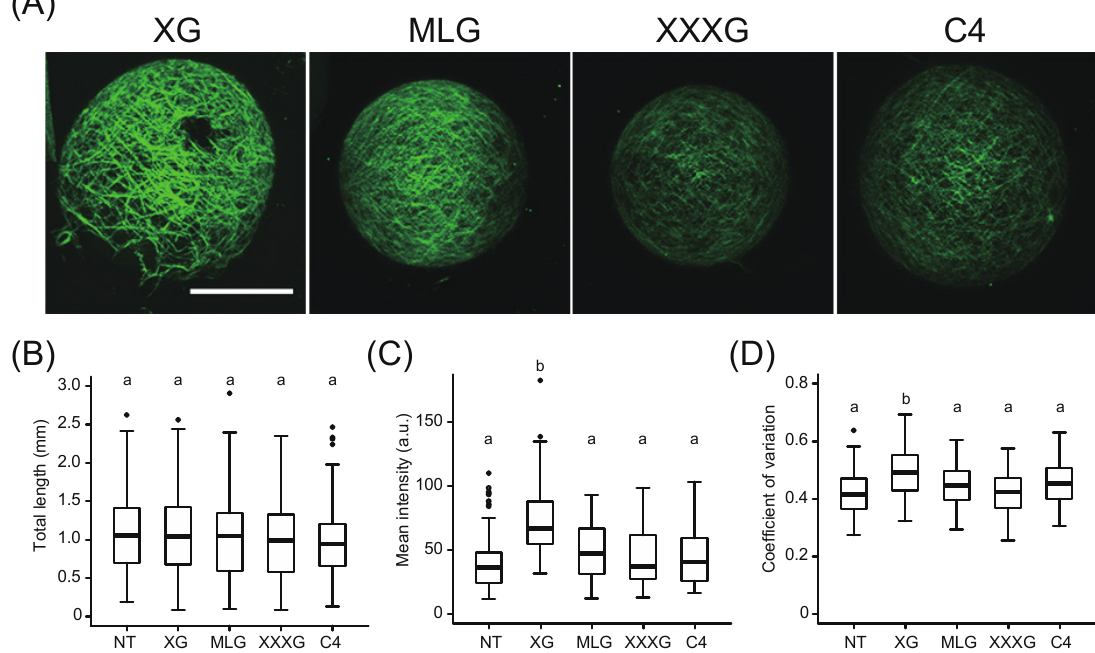
Figure 2. Effect of exogenous application of various polysaccharides or oligosaccharides on cell wall regeneration from xxt1 xxt2 protoplasts. ( A ) Representative images of Calcofluor-stained fiber regenerated from xxt1 xxt2 protoplasts incubated in the regeneration medium containing various polysaccharides or oligosaccharides for 24 h. Scale bar = 20 μ m. ( B – D ) Total length ( B ), mean intensity ( C ), and CV of fluorescence intensity distribution ( D ) of Calcofluor-stained network on the surface of xxt1 xxt2 protoplasts. NT, no treatment; XG, xyloglucan; MLG, mixed-linkage glucan; XXXG, xyloglucan oligosaccharide; C4, cellotetraose. Center lines of box-plot show the medians, boxes indicate interquartile range (IQR), whiskers indicate 1.5 IQR, and outliers are shown by dots. Significance was determined by Tukey–Kramer test. Values with “a” and “b” are statistically different at p < 0.01. n = 108 (NT), 112(XG), 109(MLG), 87 (XXXG), and 77 (C4).